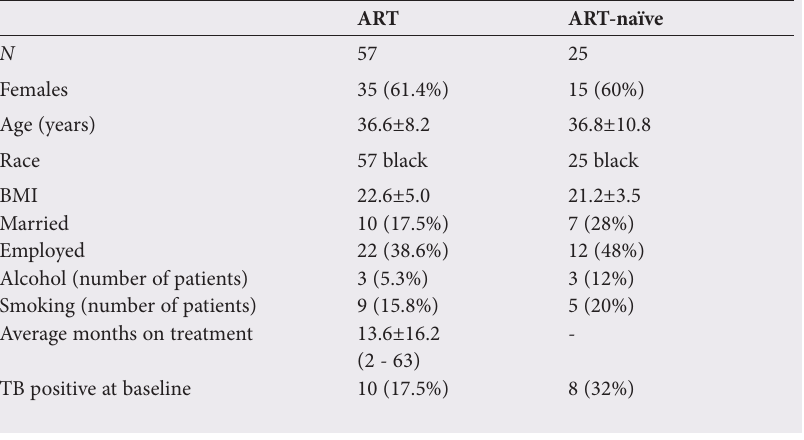
Table 1. Patient demographic information at baseline